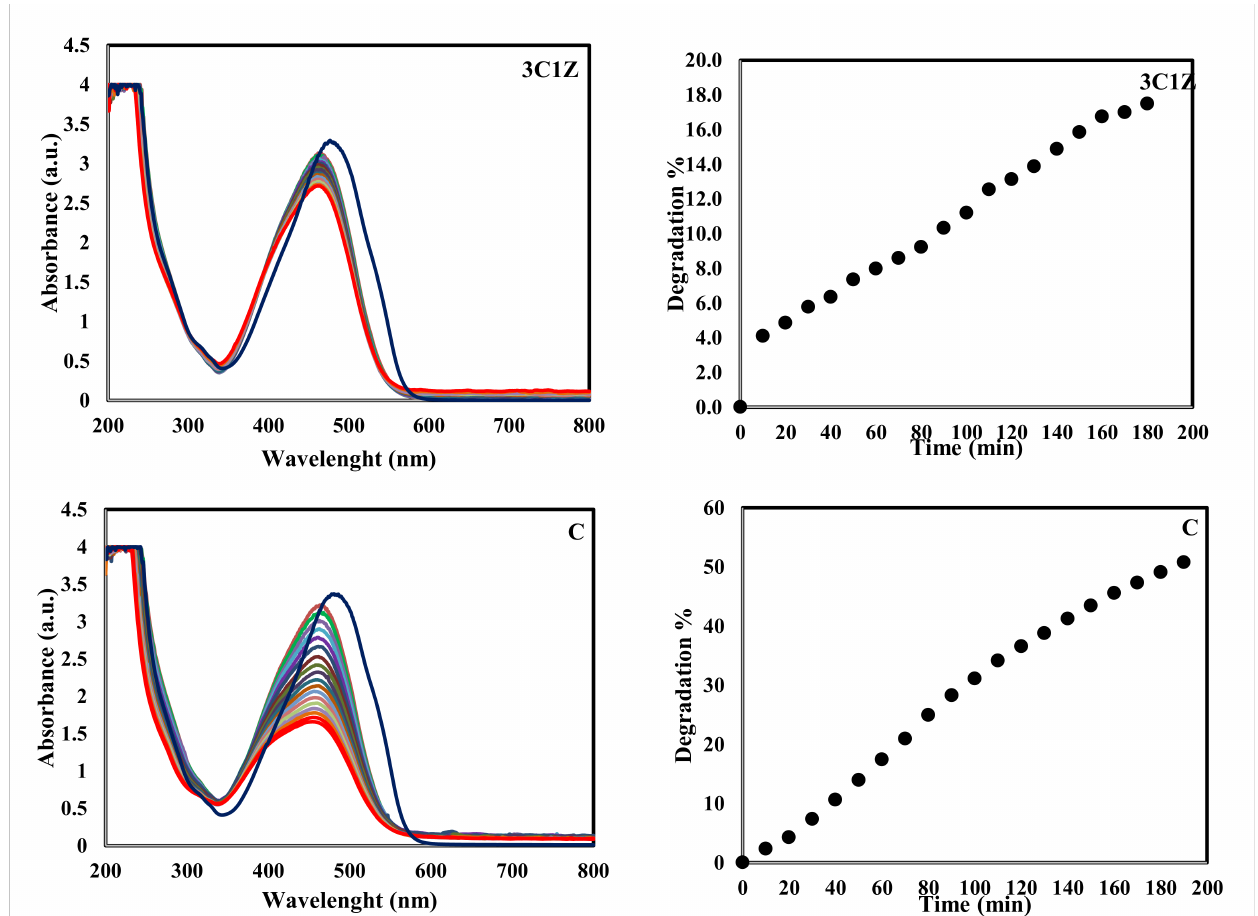
Figure 8. The UV spectra of the MO solution and the removal percentage of MO after adding the nanocomposites as a function of time.